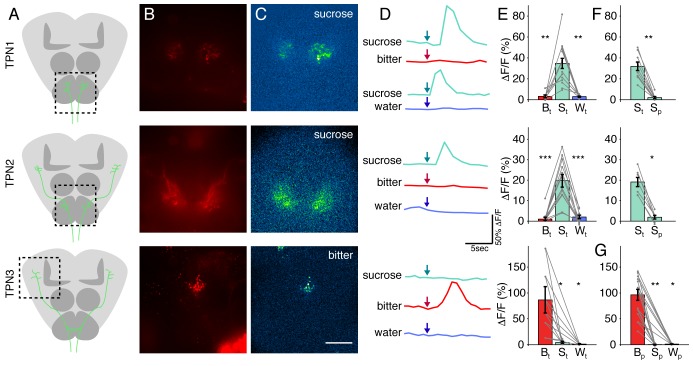
TPNs respond to taste compounds.(A) Schematic brains showing anatomy of TPNs (green) and approximate region of calcium imaging (dashed box). (B) UAS-cd8-tdTomato signal used to locate axonal arbors of each neuron type. (C) △F signal in response to sucrose (TPN1 and TPN2) or bitter solution (TPN3). Scale bar, 50 μm. (D) Example △F/F traces in response to various tastants. Arrows indicate time at which each tastant was presented. (E) Summary max △F/F for leg stimulation with each tastant. TPN1 and TPN2 respond only to sucrose, while TPN3 responds only to bitter solution. (F) Summary max △F/F for sucrose presentation to legs or proboscis for TPN1 and TPN2. Responses to sucrose are organ specific; both TPN1 and TPN2 only respond to sucrose presentation to the legs. (G) Summary max △F/F for proboscis stimulation of each tastant for TPN3. TPN3 shows strong selectivity for bitter presentation to the proboscis as well. For E-G, S: sucrose; B: bitter; W: water; t: tarsi (legs); p: proboscis. Error bars indicate mean +/-± SEM. n = 6–12. Paired Wilcoxon tests: *p<0.05, **p<0.01, ***p<0.001.